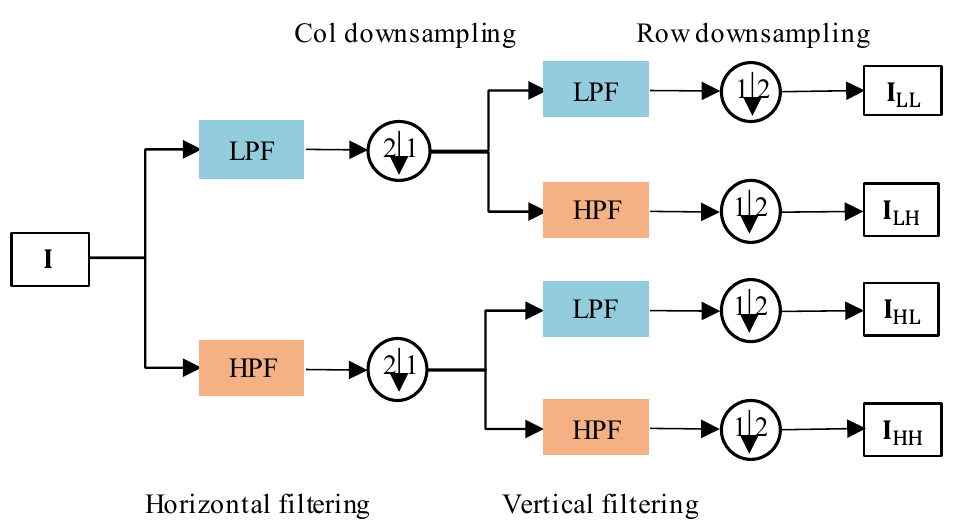
Figure 2. Illustration of 2D wavelet transform. LPF denotes the low-pass filter and HPF denotes the high-pass filter.